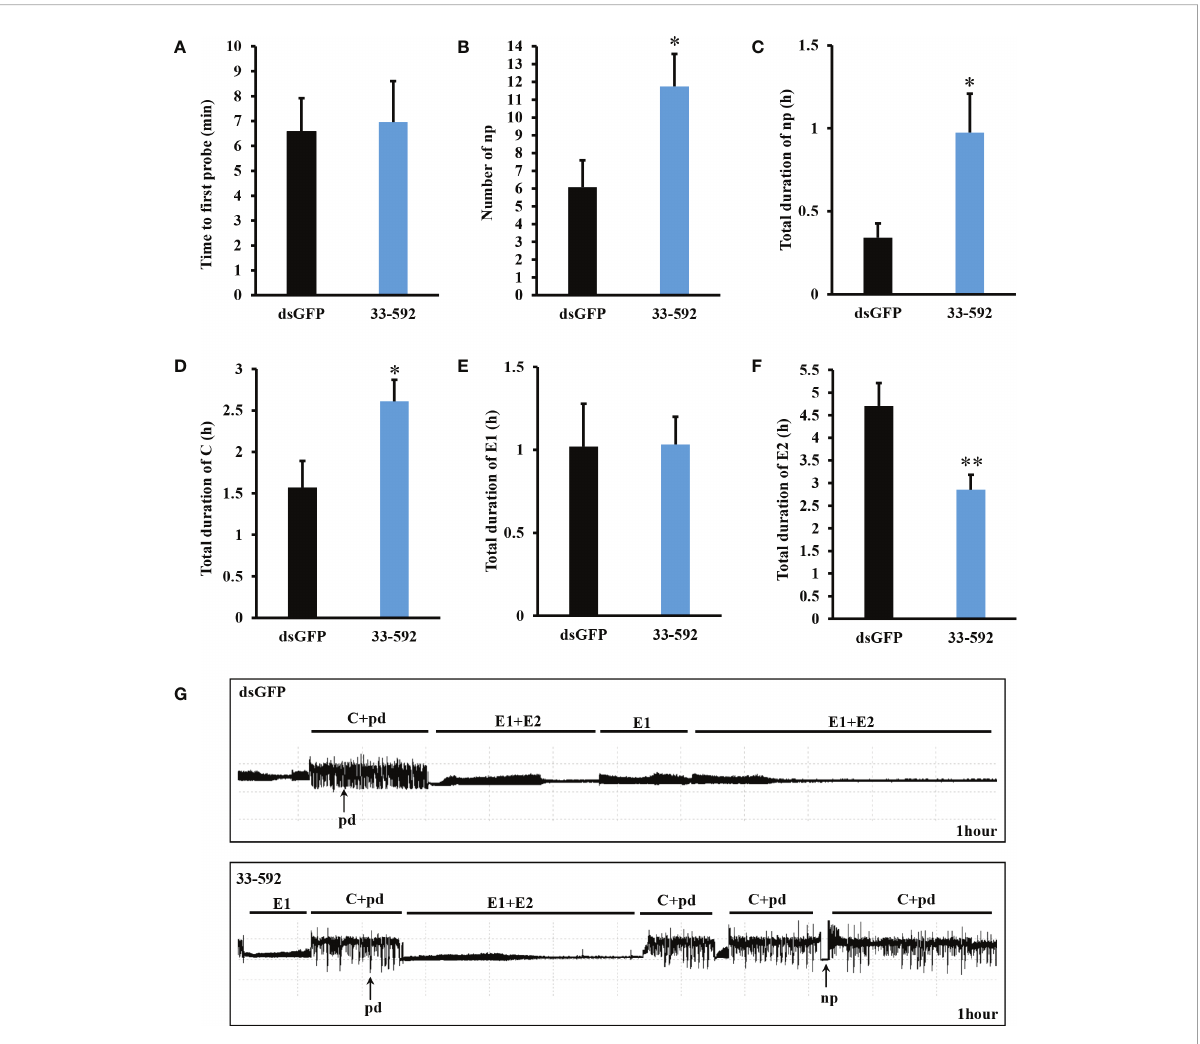
FIGURE 4 Effects of SmDSR33 silencing on feeding behavior of grain aphid based on EPG recordings. (A – F) Representative parameters of aphid feeding behavior. Non-probing (np), stylet probing (C) , intracellular stylet puncture (pd), phloem salivation (E1), and phloem ingestion (E2). Data shown are mean ± SEM. Asterisks above bars indicate signi fi cant differences between controls and treatments (Student ’ s t -test, * p < 0.05; ** p < 0.01). (G) Representative EPG waveforms of grain aphids feeding on dsGFP wheat plants and 33-592 transgenic wheat